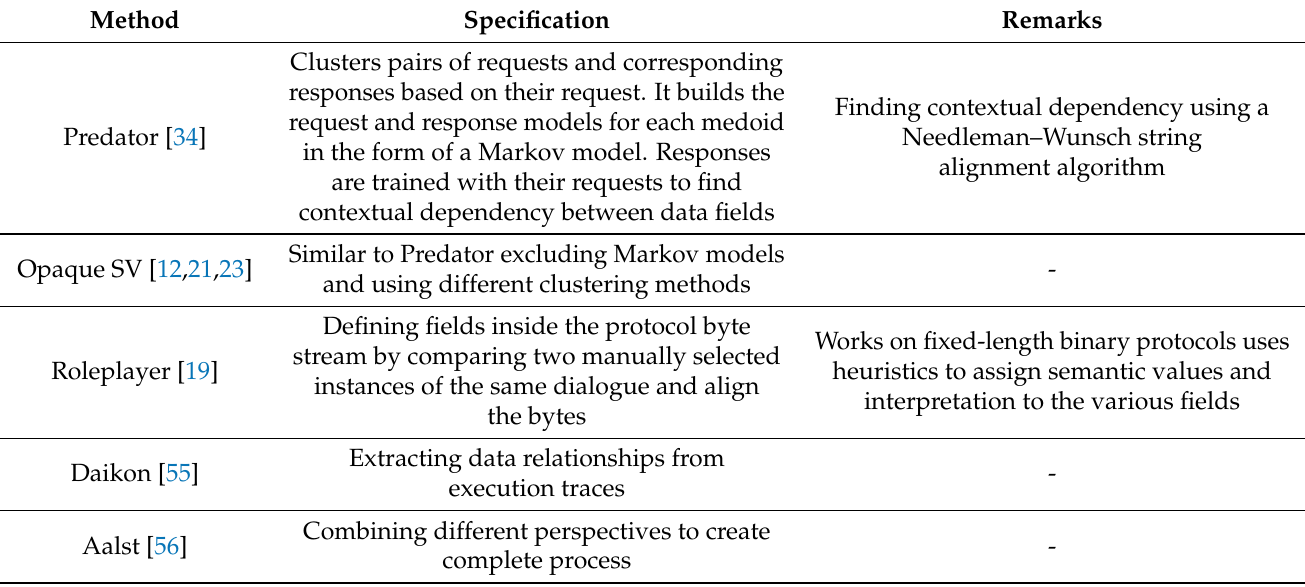
Table 5. Different approaches of data model